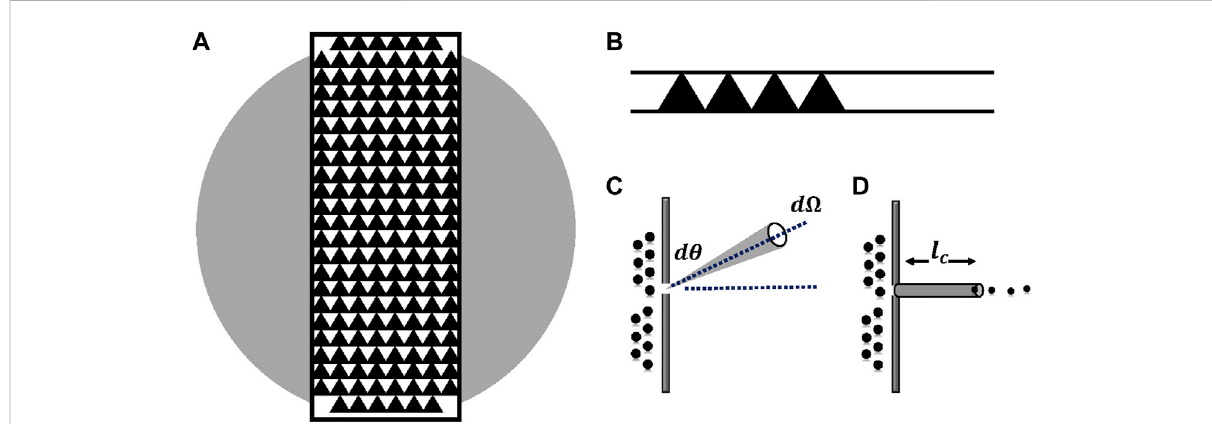
FIGURE 3 CesiumovencollimatoroftheOPCB.Frontview:Cesiumovennozzleisrectangular,consistsofmanytriangularthintubes(0.003 mm 2 ),witha total area of 12 mm 2 . (A) Zoom out (B) zoom in. Side view: (C) no collimator (D) collimator.